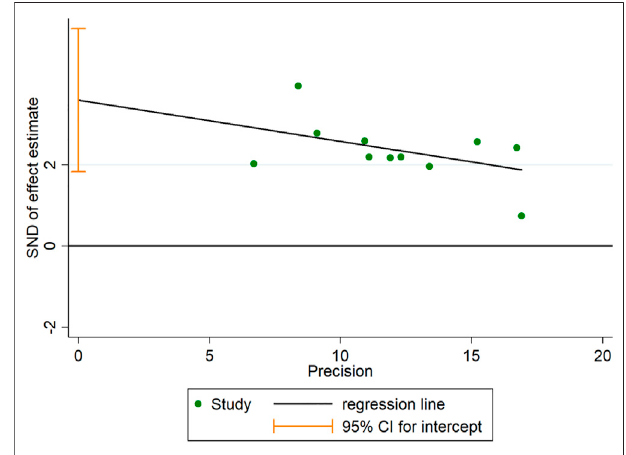
FIGURE 15 | funnel plot.